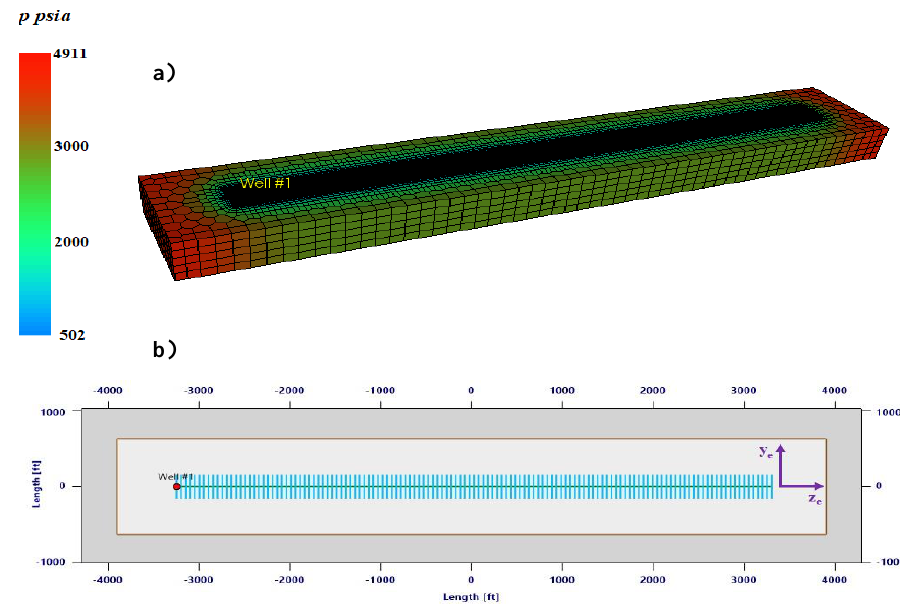
Figure 11. ( a ) Three-dimensional (3D) numerical model and the gridding built to generate rate data for well to type well (W/TW) cases. The model presents the pressure distribution at the final time step (30 years) of the constant pressure production simulation for W/TW = 1.0 case. ( b ) Map view of the numerical reservoir model used for the W/TW = 1.0 case. After [7].